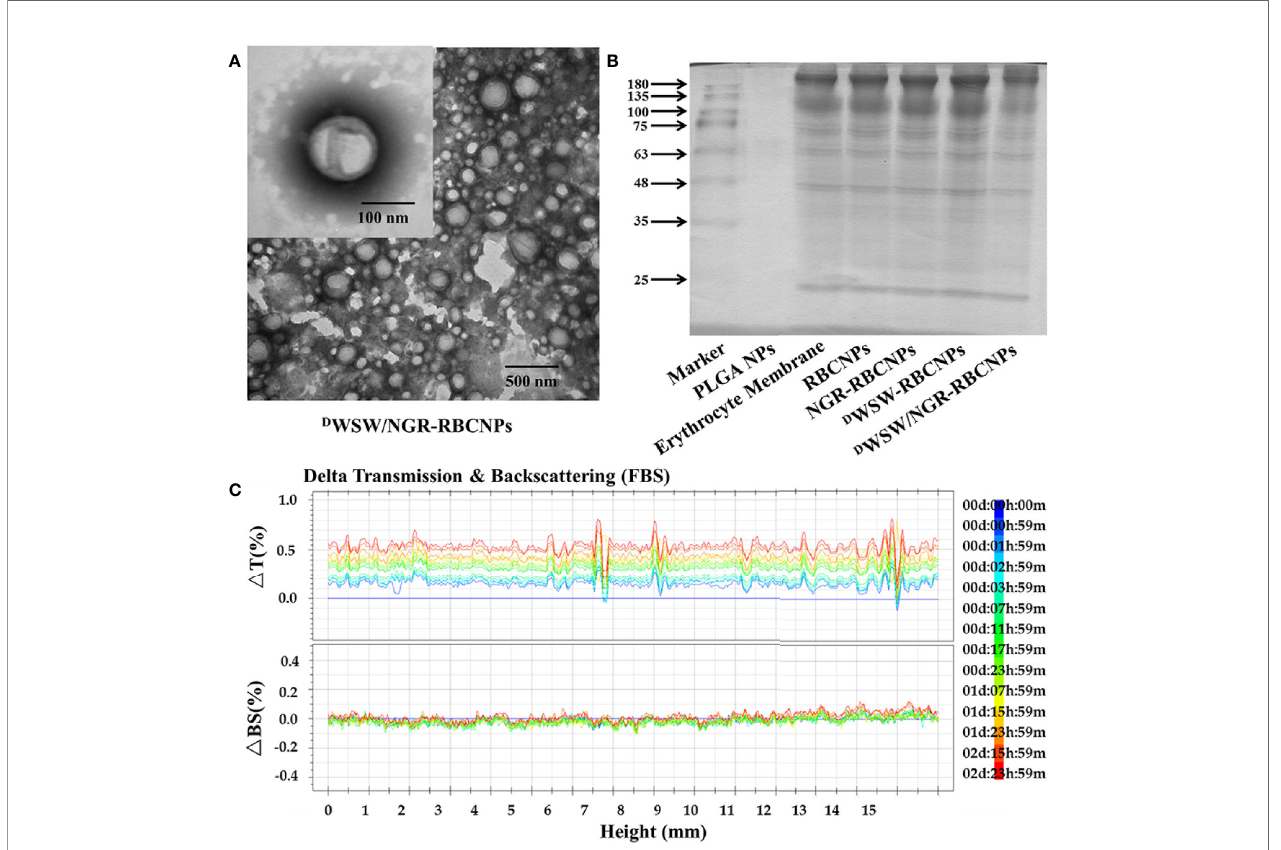
FIGURE 3 | Characterization of nanoparticles. Transmission electron microscopy (TEM) photos of D WSW/NGR-RBCNPs. (A) Nanoparticles showing the core-shell structure. (B) Erythrocyte membrane proteins in different nanoparticles, showing the protein had not been lost. Similar bands of protein appear in the same location. (C) Stability of EFL1-loaded D WSW/NGR-RBCNPs in the presence of FBS; stability fl uctuated within a range of 2%. No serious aggregation or sedimentation of the nanoparticles during the measurement period.